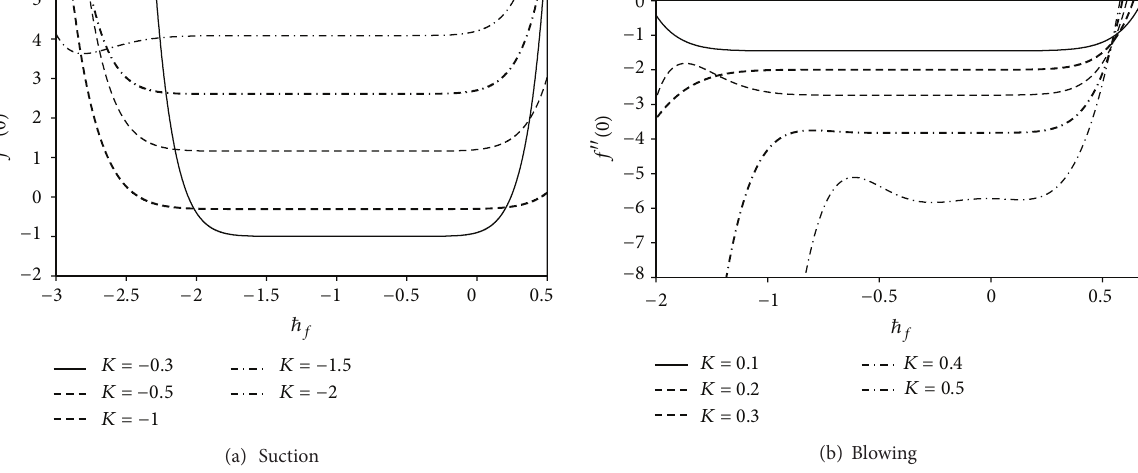
Figure 2: The ℎ 𝑓 curve of 𝑓 󸀠󸀠 (0) using 10th-order HAM approximation for the cases 𝑆 = 0.8 and Pr = 1 .